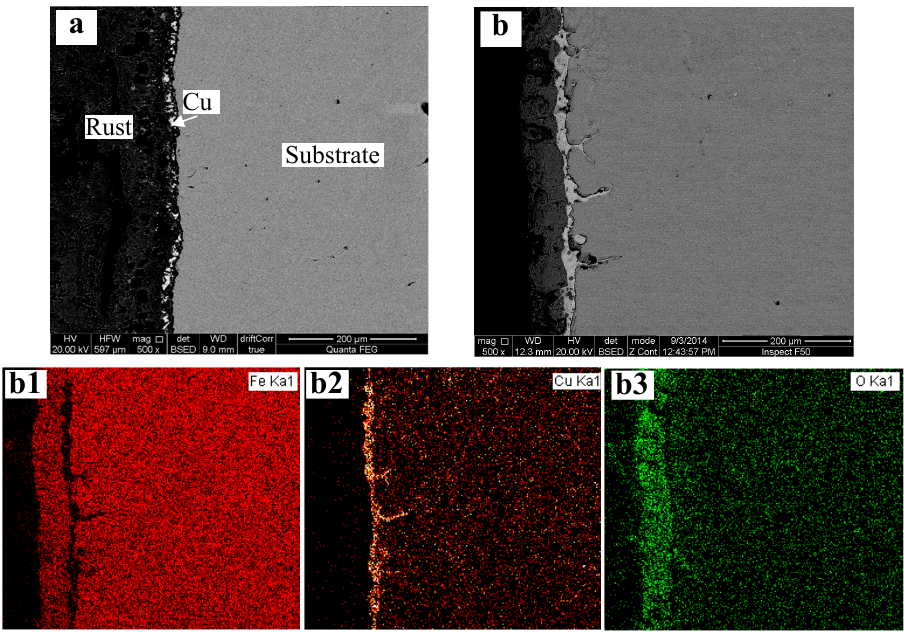
Figure 1. Back scattered electron (BSE) morphology of steel 1 after heading at 1000 °C ( a ) and 1150 °C ( b ) for 2 h and EDX surface scan of Fe ( b1 ), Cu ( b2 ) and O ( b3 ) in ( b ).